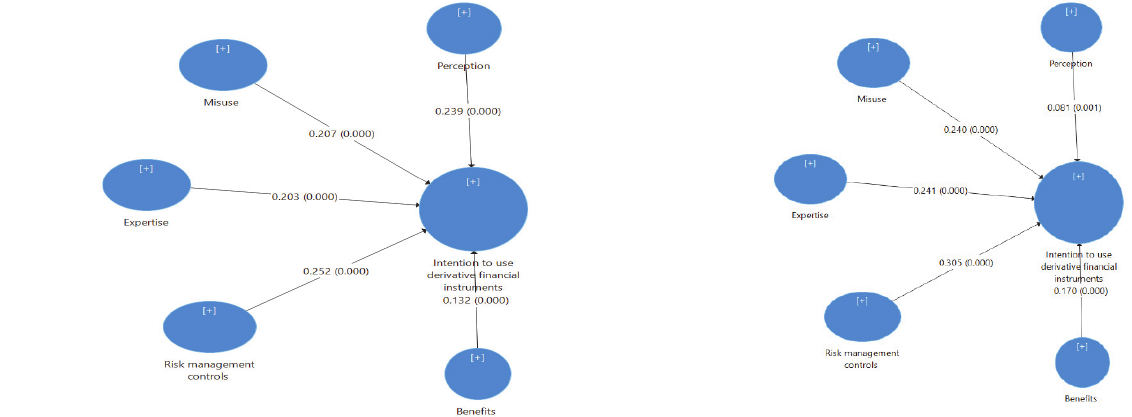
Fig. 3. Results of multi-group analysis with male group Fig. 4. Results of multi-group analysis with female gender